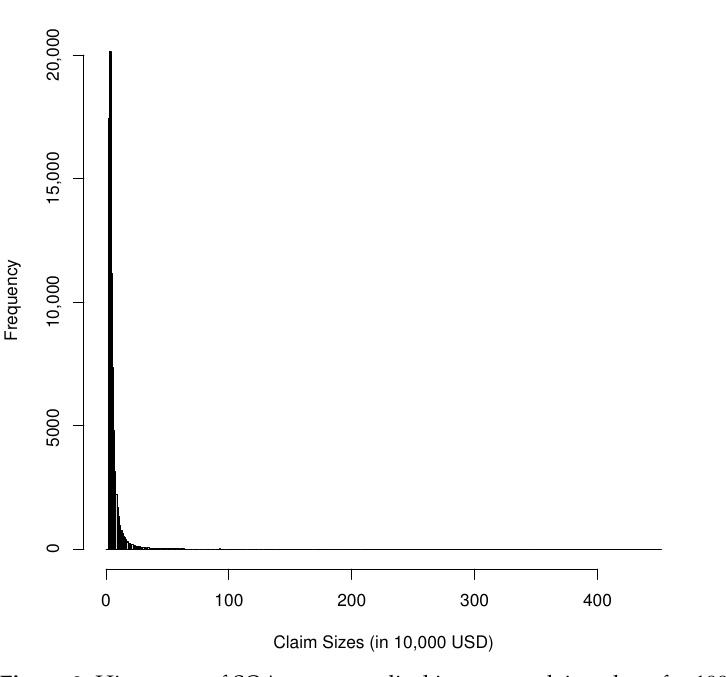
Figure 9. Histogram of SOA group medical insurance claims data, for 1991. Table 5. Comparisons of different models with the Norwegian fire insurance data, for 1990.